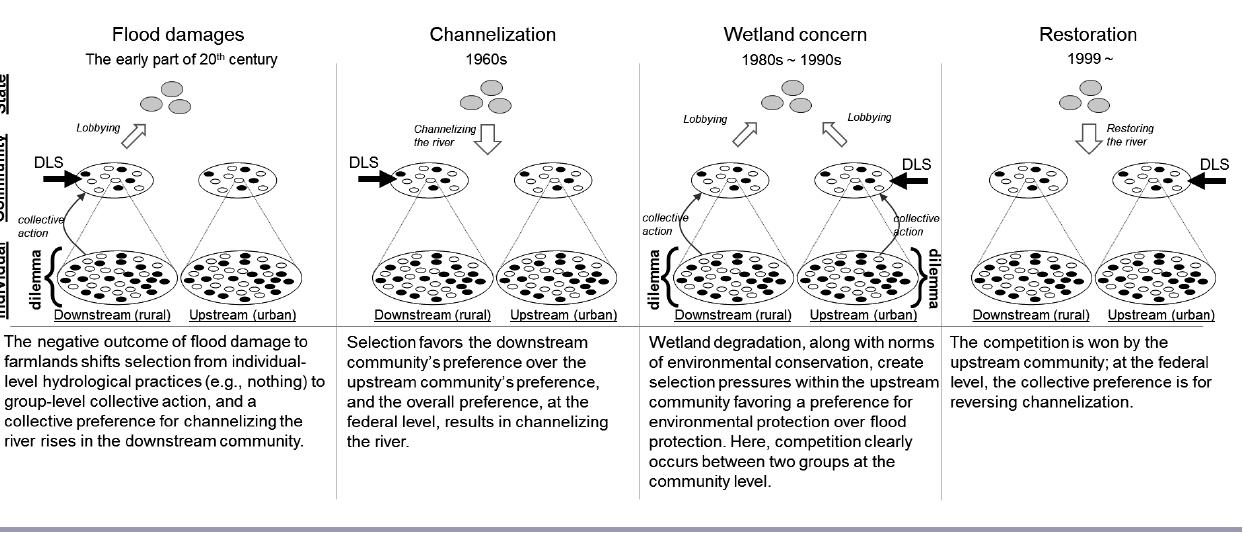
Fig. 6 . Likely changes in the level of selection for social preferences and policy concerning river engineering and management in the Kissimmee River Basin (circa early 20th century to present). DLS = dominant level of selection (hypothesized). White and black ovals represent social units with different cultural norms for flood protection practices. Braces ({) represent social dilemmas. Adapted from Hanes and Waring